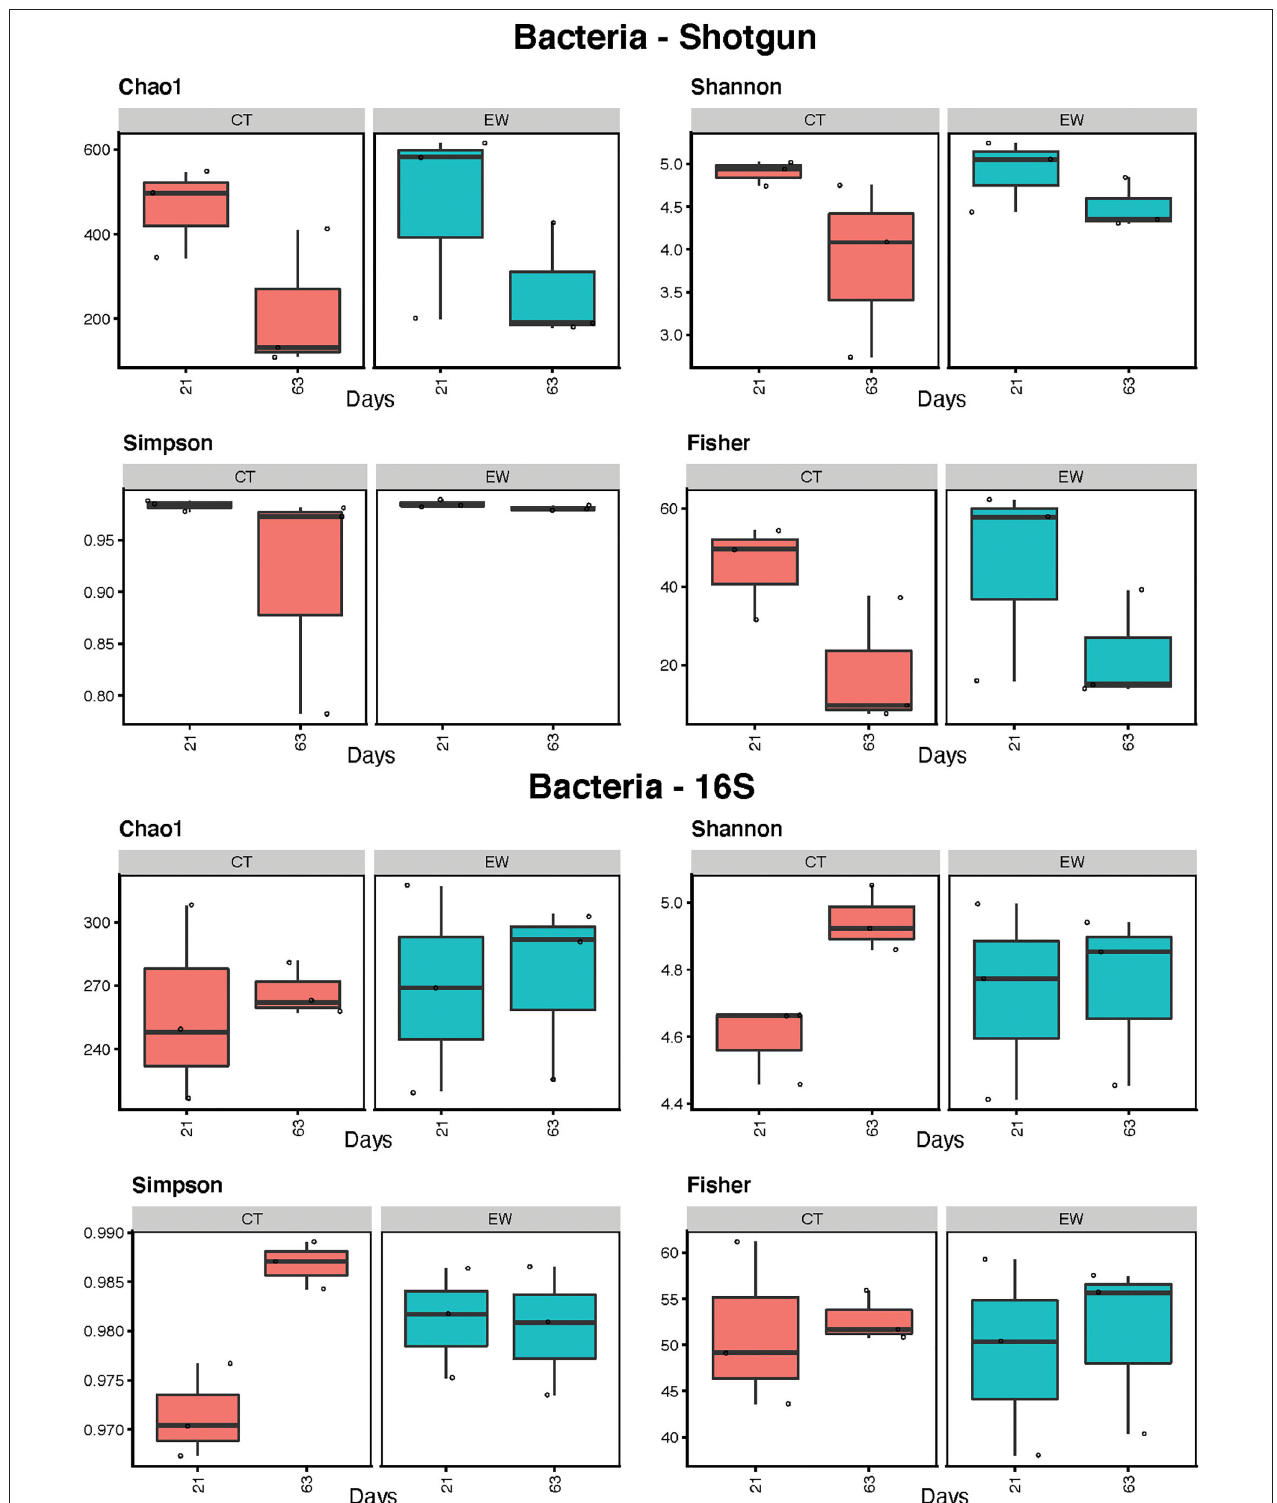
FIGURE 2 | Bacterial alpha-diversity estimates (Chao1, Shannon, Simpson, and Fisher indices) for treatment (control, CT; earthworm, EW) and age (21 and 63 days) groups in shotgun metagenomic and 16S metataxonomic strategies.